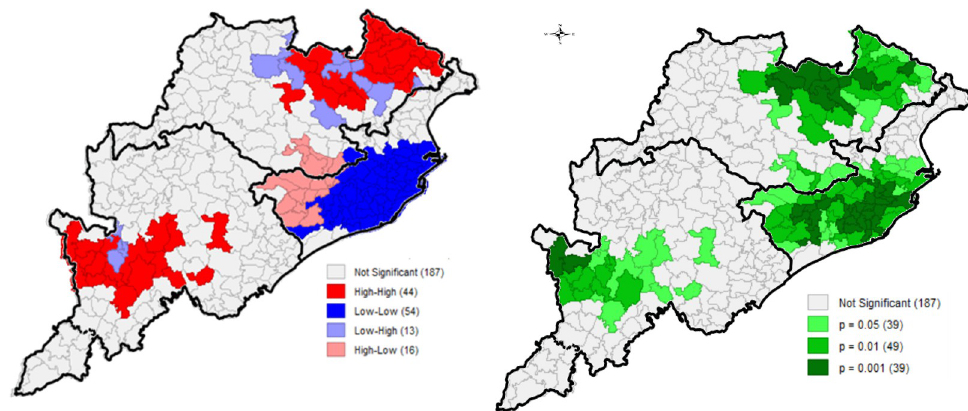
Fig 5. Bivariate LISA cluster and significance map of underweight vs first pregnancy � 19 years of age, block-wise, CCM-II, 2014–15, Odisha, India.